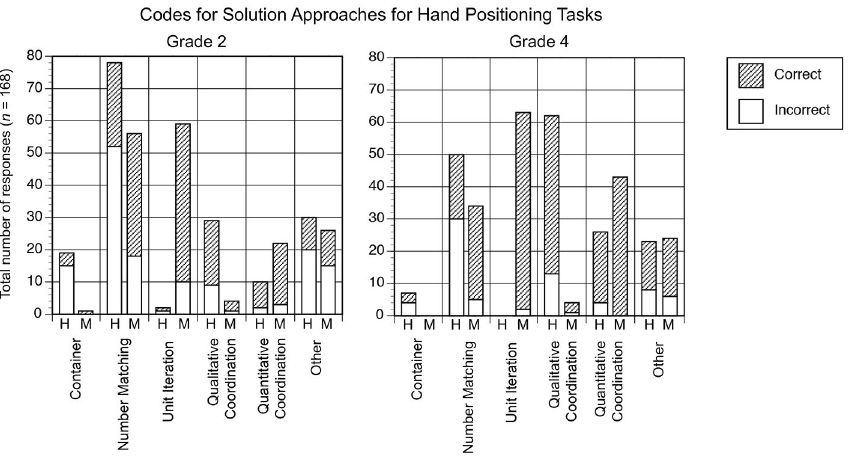
Figure 4. Codes for hour and minute